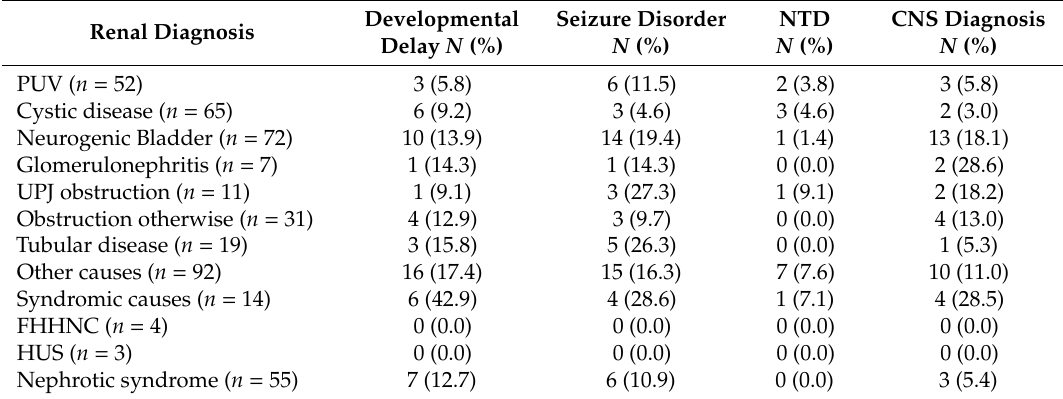
Table 4. Frequency of developmental delay, seizure disorder, NTD (Neural Tube Defects) and CNS (Central Nervous System) diagnosis in each renal diagnosis.